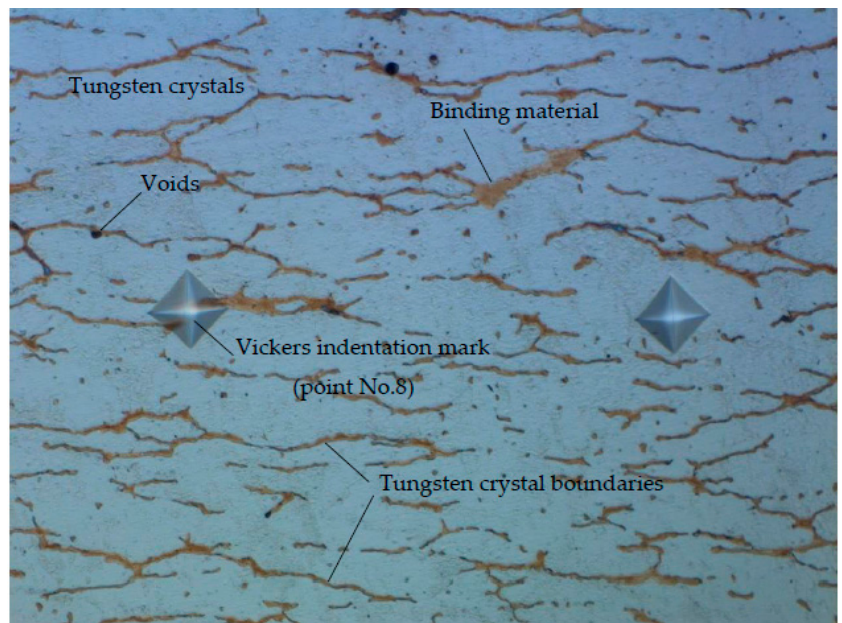
Figure 5. Microscope image of microstructure (cross-section) in the base material outside the HAZ.